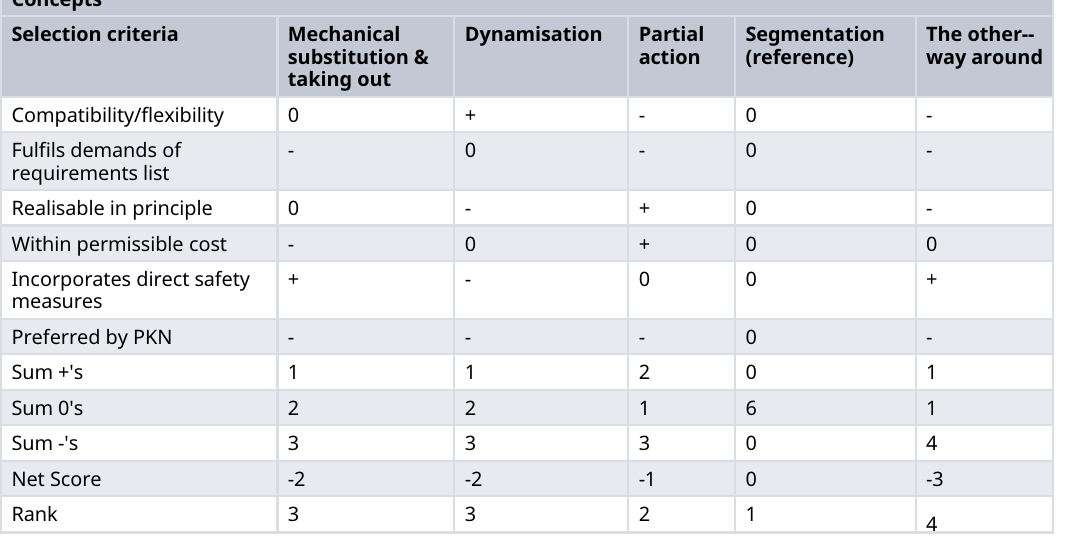
Table 3. The concept-screening